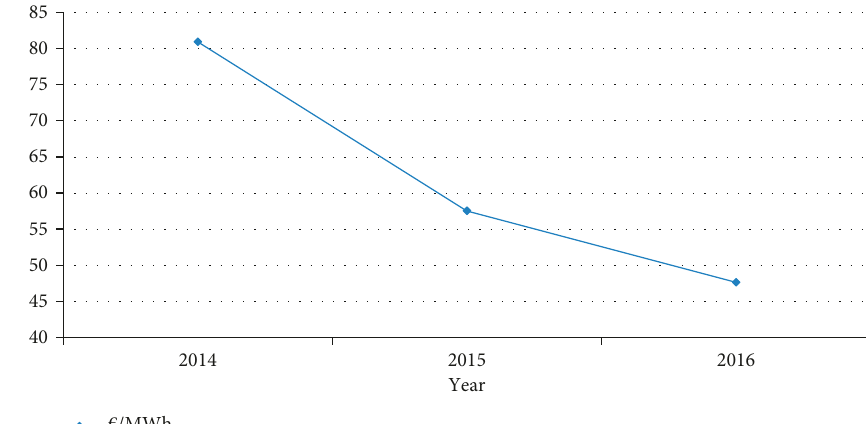
Figure 10: Sicilian electricity (zonal) price (period 2014–2016).